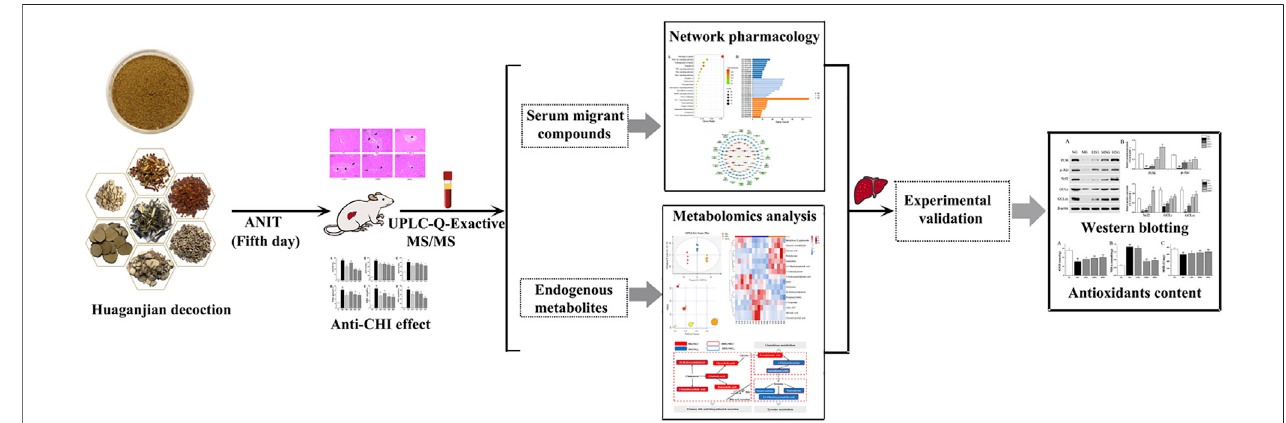
FIGURE 1 | The graphical abstract of this